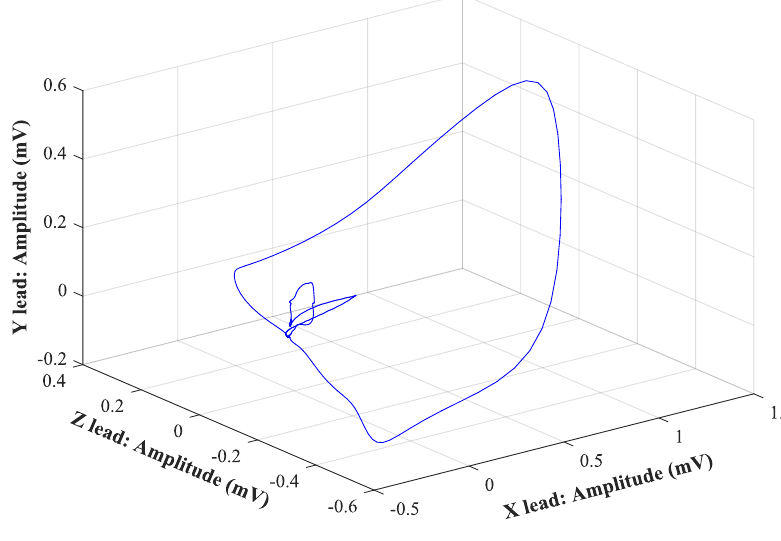
Figure 3. 3-D image of